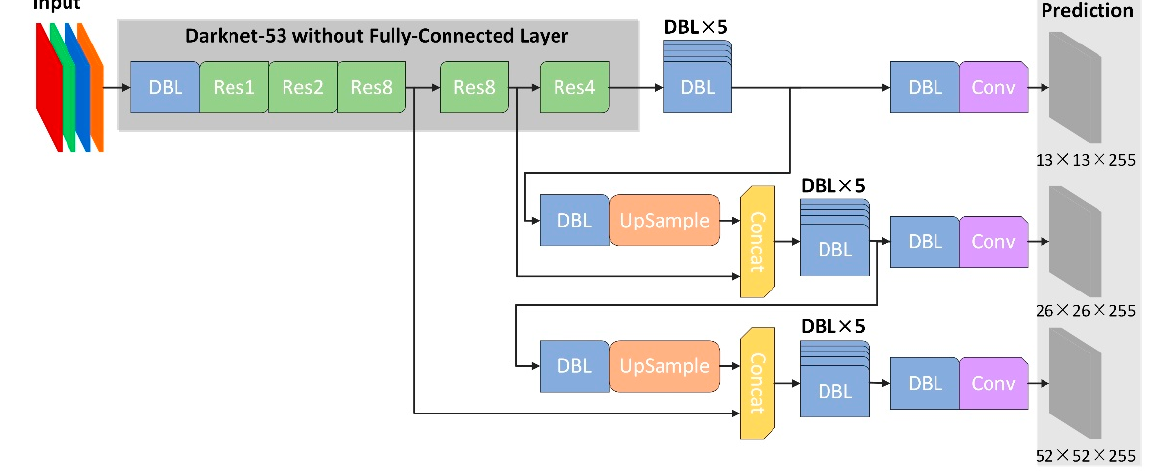
Figure 4. Early fusion architecture based on YOLOv3.